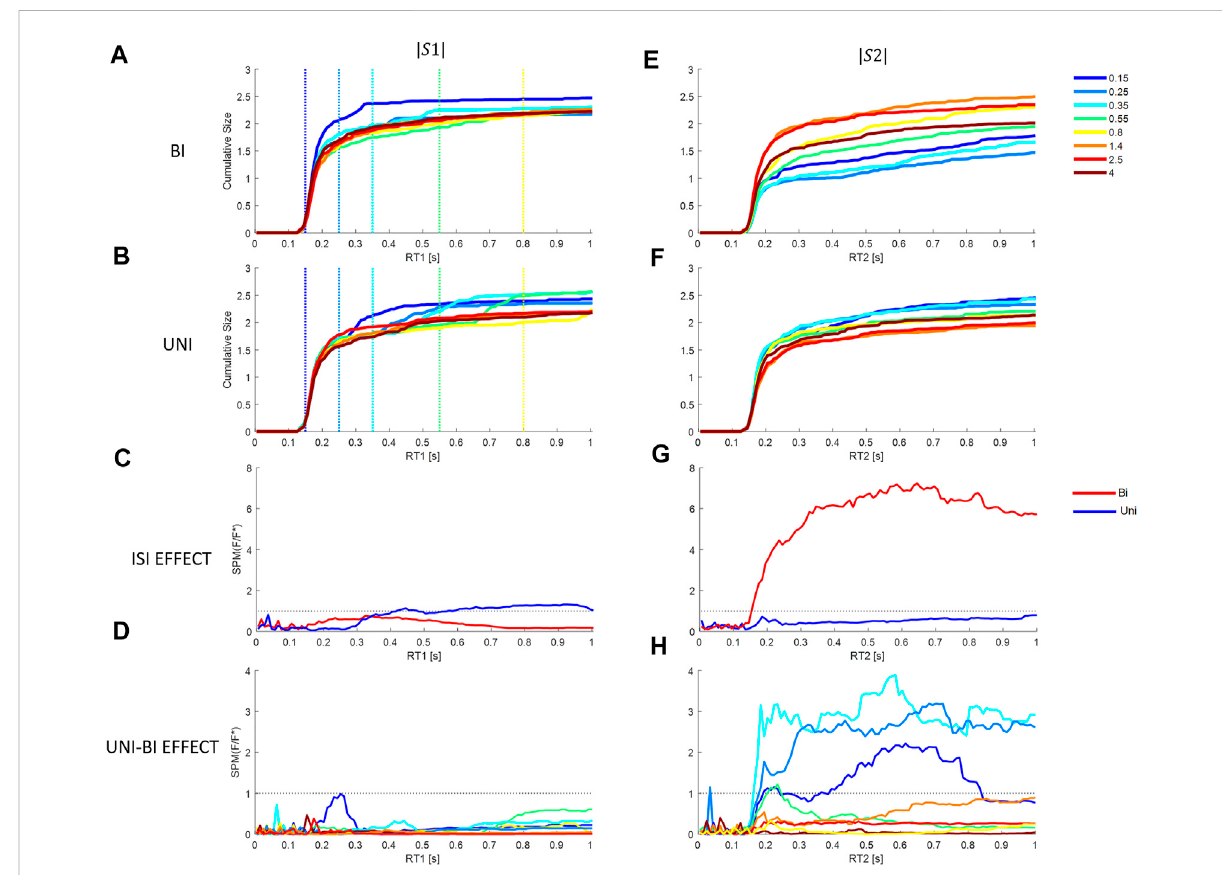
Effect of Inter stimuli interval and direction on cumulative size response from model M3 at each latency. First column (stim1), second column (stim2).Rows1and2:Cumulativeresponsesize foreachISI(colorsinthebottomrightlegend)relativetothestimulussize.Row1(A, E):Bidirectional pairs.Row2(B,F):Unidirectionalpairs.Row3(C,G):SPMTimevarying(F/F*atalpha0.05):EffectofISIsateachlatency.Bi(Red)andUni(blue).Row4 (D, H): SPM Time varying (F/F* at alpha 0.05): Effect of paired direction (Bi v Uni). Colors show ISIs. Rows 3 – 4: Horizontal dotted line shows F/F* = 1 (threshold required for signi fi cance difference at alpha = 0.05). Message: Non-linearity: triggered reactions or refractoriness is revealed by signi fi cant effect of